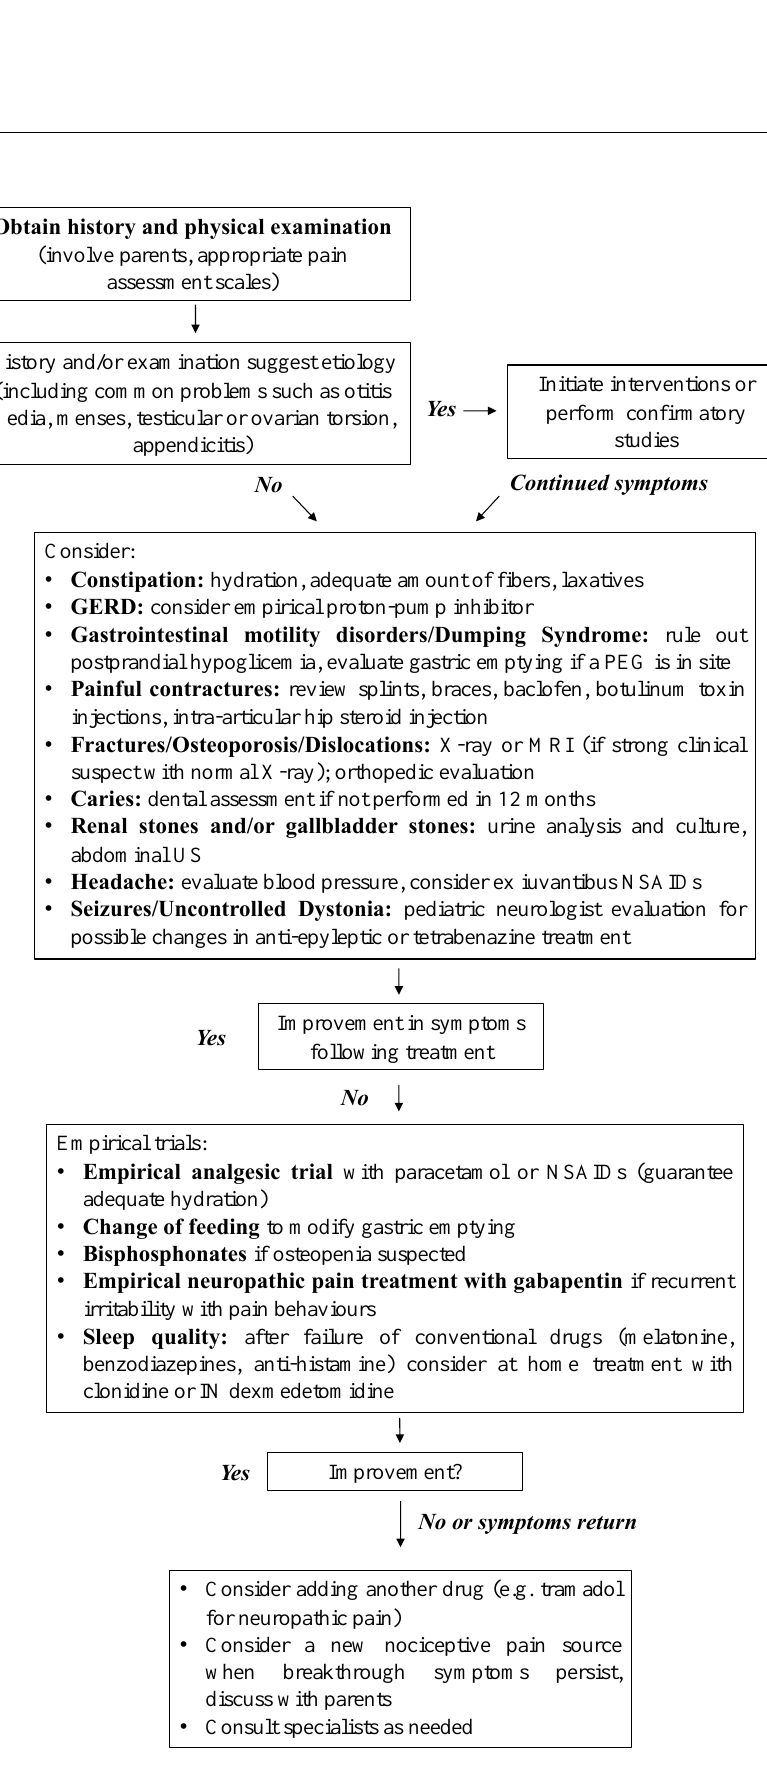
Figure 2. Diagnostic workup for pain in patients with cognitive impairment. Modified from Hauer and, Houtrow, Pain Assessment and Treatment in Children with Significant Impairment of the Central Nervous System. Pediatrics 139 (2017).